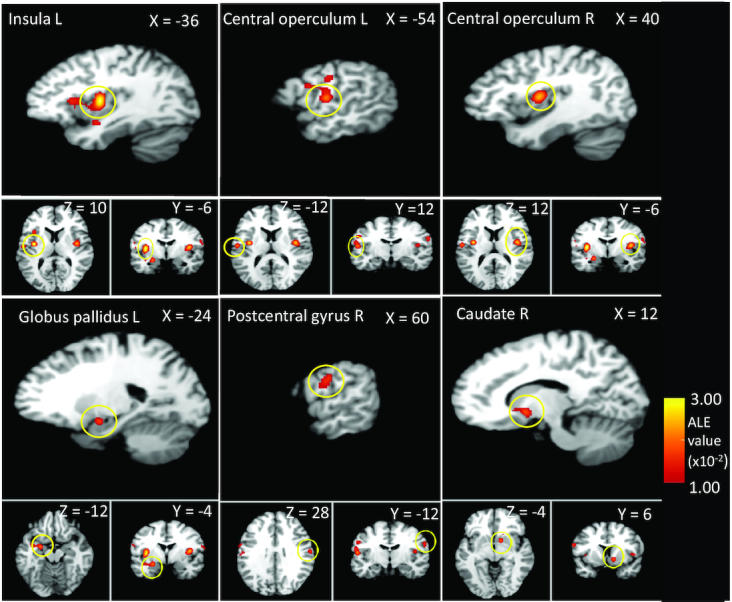
Localization of significant ALE clusters from the sucrose minus control contrast, from ALE meta-analysis of sweet taste in human adults. GingerALE output overlaid onto a standard template (Colin27_T1_seg_MNI.nii) in MNI space. ALE, activation likelihood estimation; MNI, Montreal Neurological Institute.